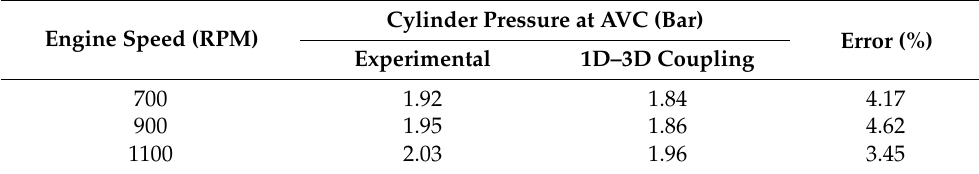
Table 2. Cylinder pressure results of the 1D–3D gas flow analysis and experiment when the air-intake valve was closed (580 CA ◦